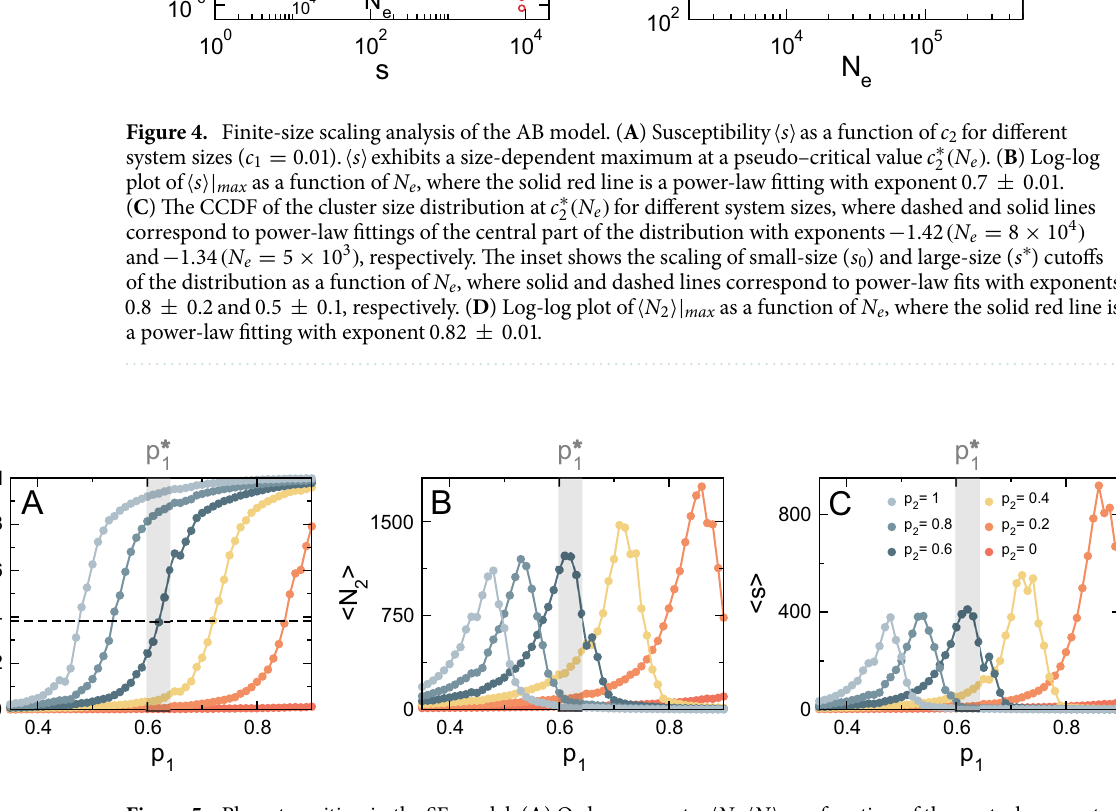
Figure 5. Phase transition in the SE model. ( A ) Order parameter (cid:31) N g / N (cid:30) as a function of the control parameter p 1 for a system of size N = 1 × 10 4 and different values of p 2 . Shaded region depicts the pseudo–critical value p ∗ 1 for p 2 = 0.6 . Dashed line denotes the proportion of nodes belonging to the largest cluster at the critical point for p 2 = 0.6 . ( B ) Size of the second largest cluster (cid:31) N 2 (cid:30) as a function of p 1 . ( C ) Susceptibility (cid:31) s (cid:30) as a function of p 2